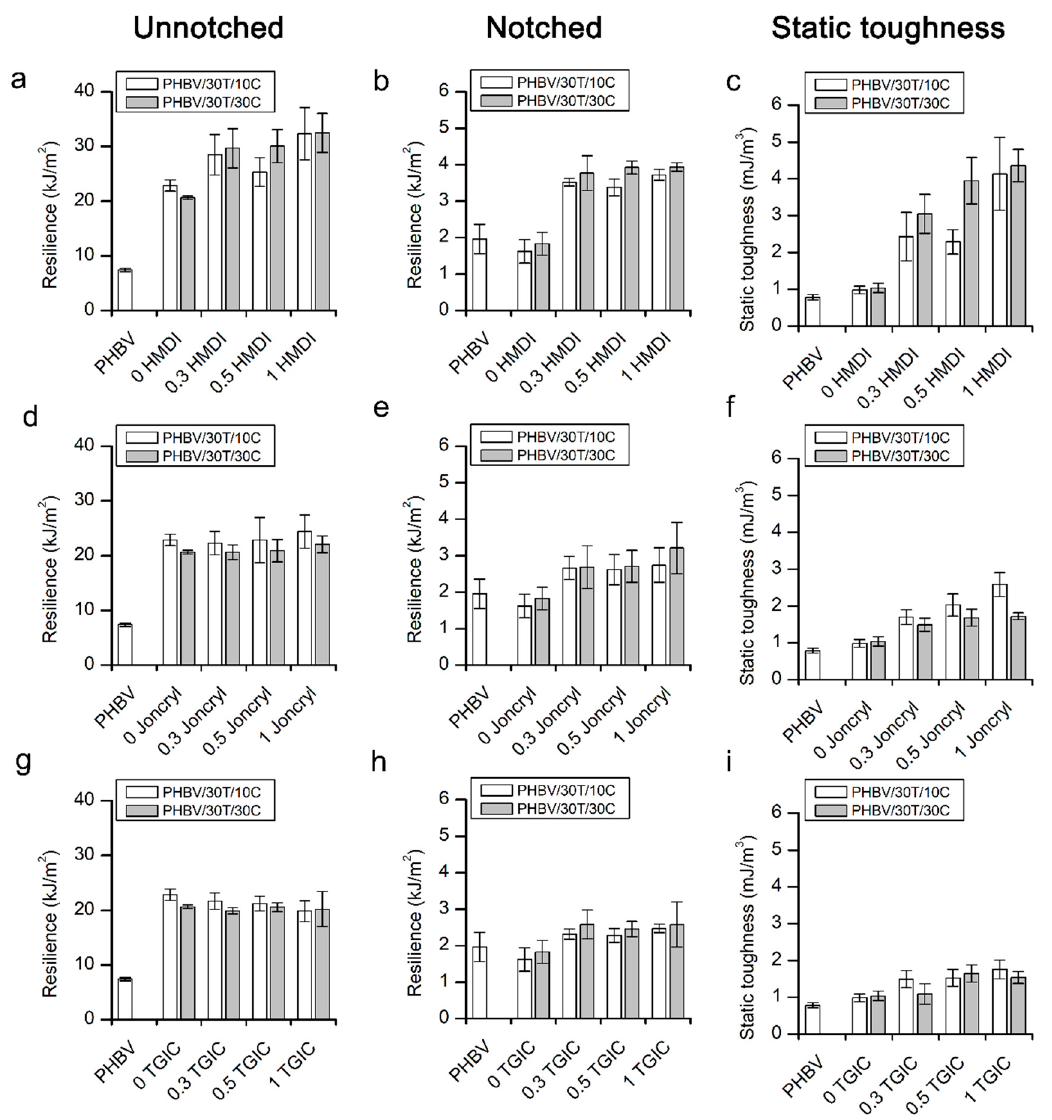
Figure 8. Charpy’s impact results for unnotched specimens ( a , d , g ), notched specimens ( b , e , h ) and static toughness from the area below the strain–stress curve ( c , f , i ).